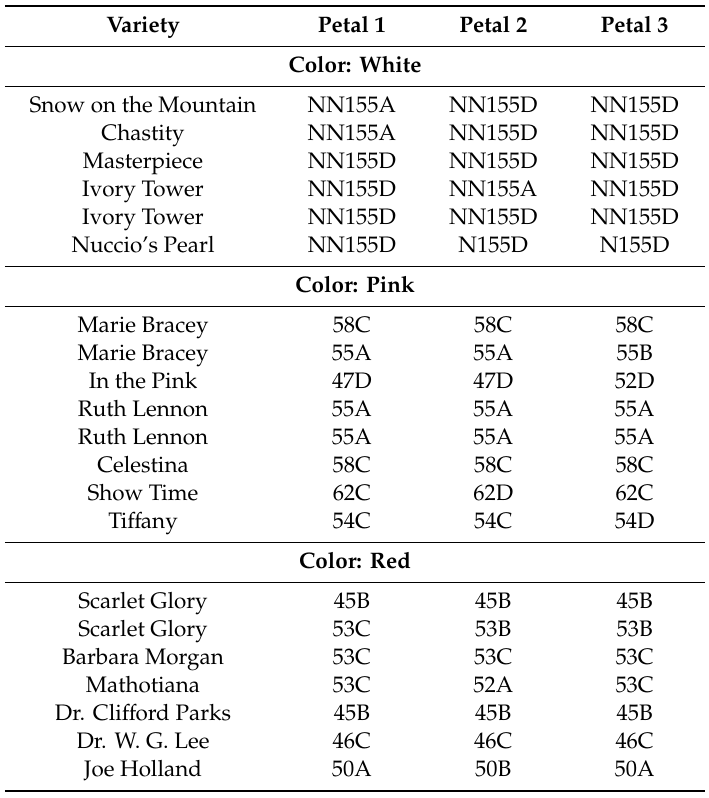
Table 2. The Royal Horticultural Society (RHS) Colour Chart [10] measurements for sampled camellia ( Camellia japonica L.) in the South Carolina Botanical Garden with information from the International Camellia Society (2020)